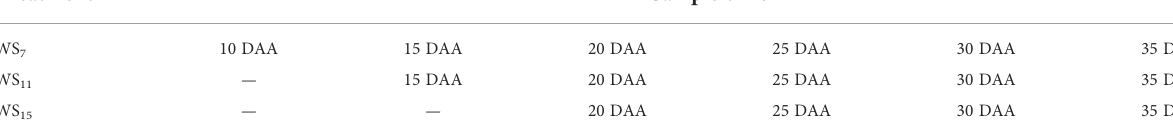
TABLE 1 Sampling time for different treatments under waterlogging and shading after